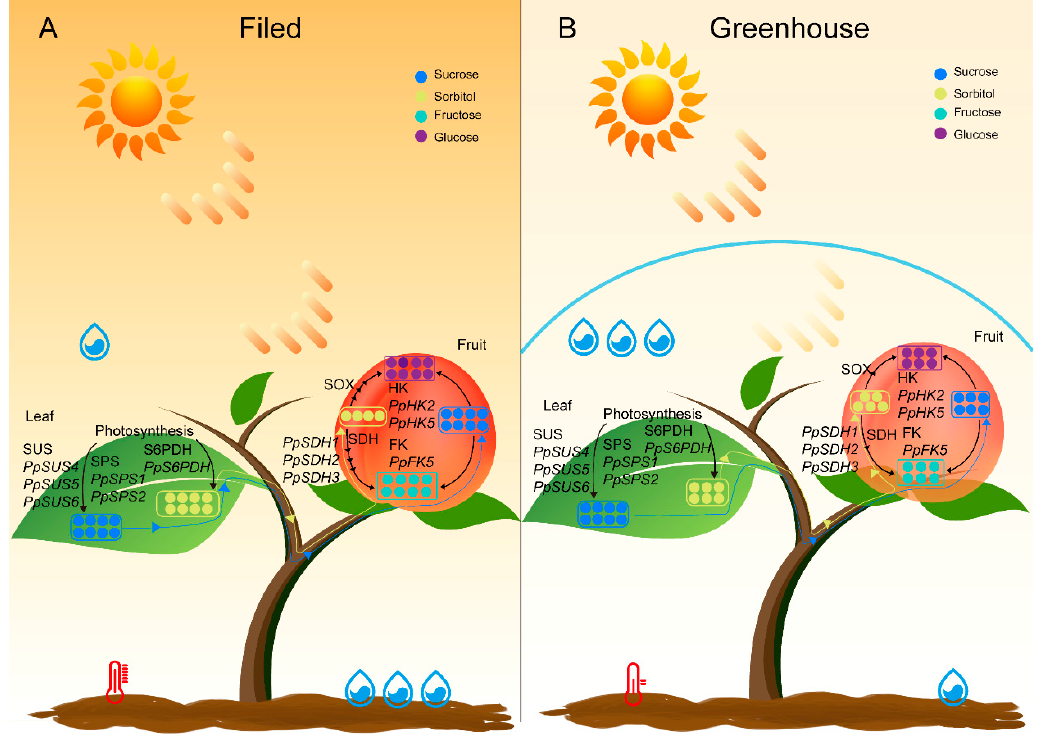
Figure 12. Proposed model for the differences in sugar transport in peaches from trees grown in field and greenhouse environments. ( A ) presents the field environment, and ( B ) presents the green- house environment, where the blue curve represents the greenhouse film. For environmental indi- cators, the deeper the background color, the higher the temperature and light intensity. The more water droplets that are present, the greater the humidity. The greater the thermometer index, the higher the temperature. The blue ball represents sucrose, the yellow ball represents sorbitol, the cyan ball represents fructose, and the p urple ball represents glucose. The greater the number of balls, the greater the content. The greater the number of arrows, the greater the transport or decom- position.